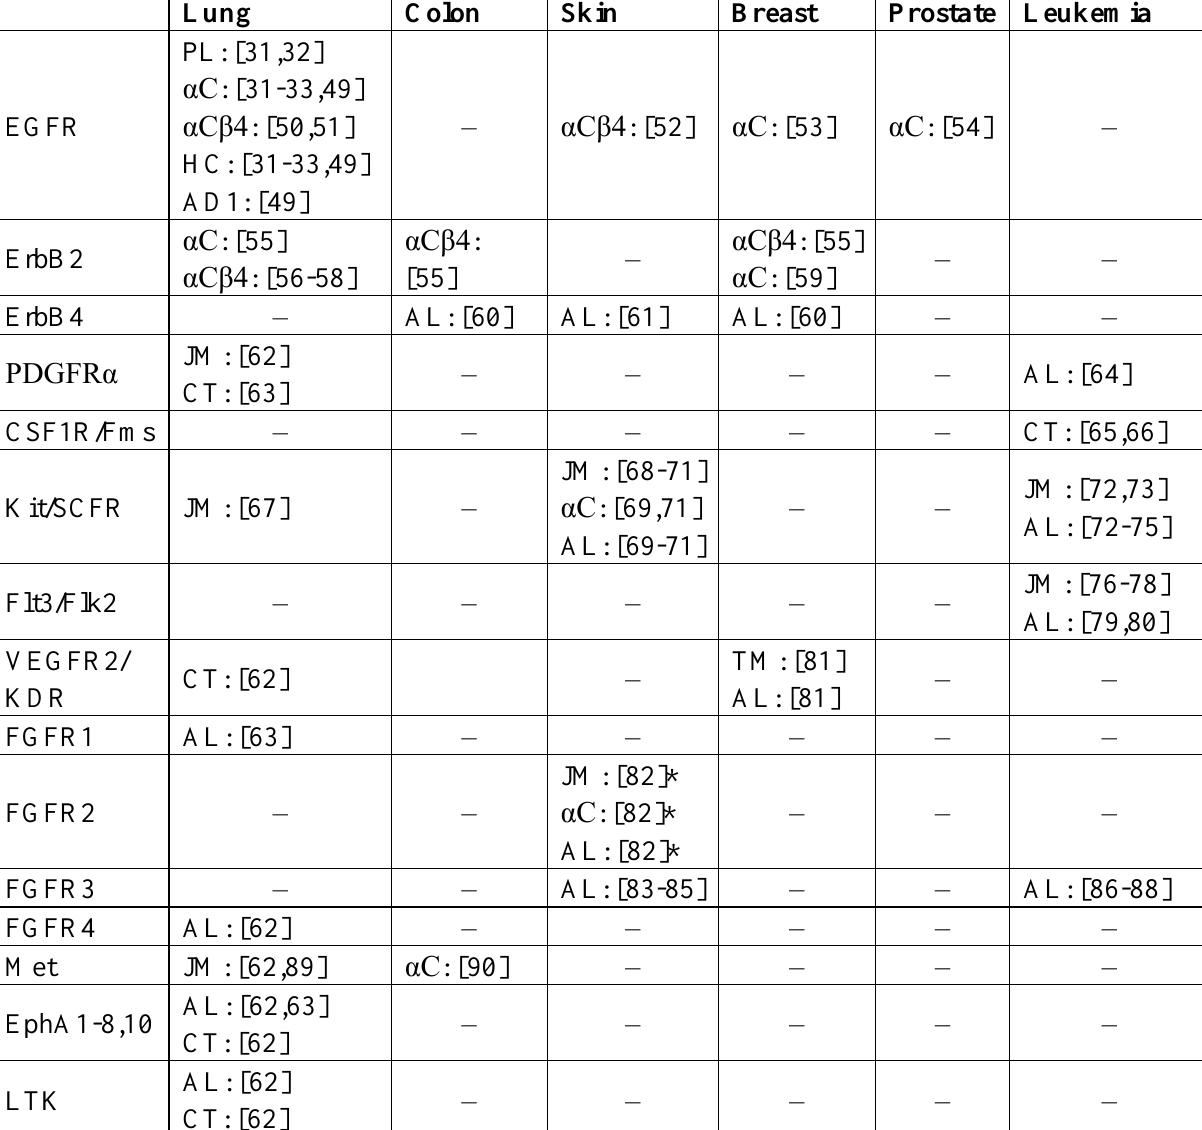
Table 1. Currently known clinically identified activating or biologically significant cytoplasmic domain mutations in RTKs classified by kinase sub-domains associated with the most lethal tumor types. * denotes a loss-of-function mutation, JM: juxtamembrane domain, PL:P-loop, αC: αC-helix, αC-β4: αC-β4 loop, HC: Hydrophobic Core, AL: A-loop, AD1: Asymmetric Dimer Interface in ErbB family, AD2: Asymmetric Dimer Interface in Ret, CT: C-terminal Tail. See also Table